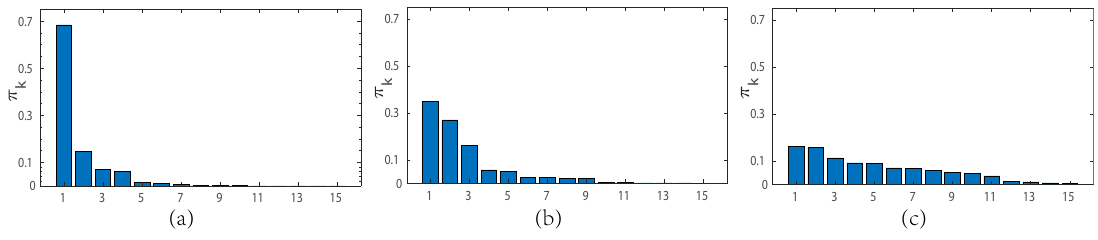
Figure 2. Stick breaking process under different concentration parameters γ . ( a ) γ = 1; ( b ) γ = 5; ( c ) γ =